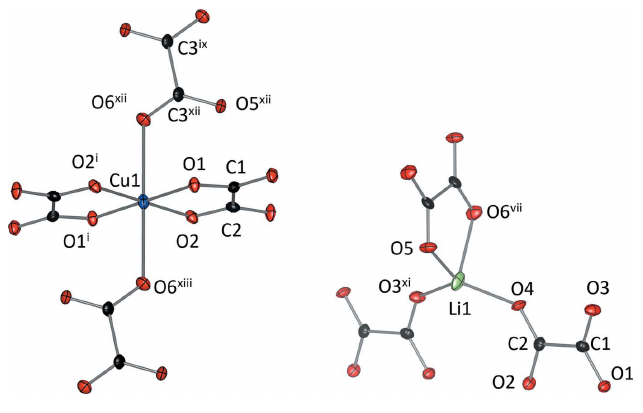
Figure 5 Coordination environments of Cu 2+ and of Li + in the crystal structure of K 2 Li 2 Cu(C 2 O 4 ) 3 (cid:2) 2H 2 O (III). Colour code: Li (green), Cu (Blue), C (black) and O (red). Displacement ellipsoids are drawn at the 50% probability level. [Symmetry codes: (i) (cid:3) x + 2, (cid:3) y + 2, (cid:3) z + 2; (vii) (cid:3) x , (cid:3) y , (cid:3) z + 1; (ix) x + 1, y + 1, z ; (xi) x (cid:3) 1, y , z ; (xii) (cid:3) x + 1, (cid:3) y + 1, (cid:3) z + 1; (xiii) x + 1, y + 1, z + 1].